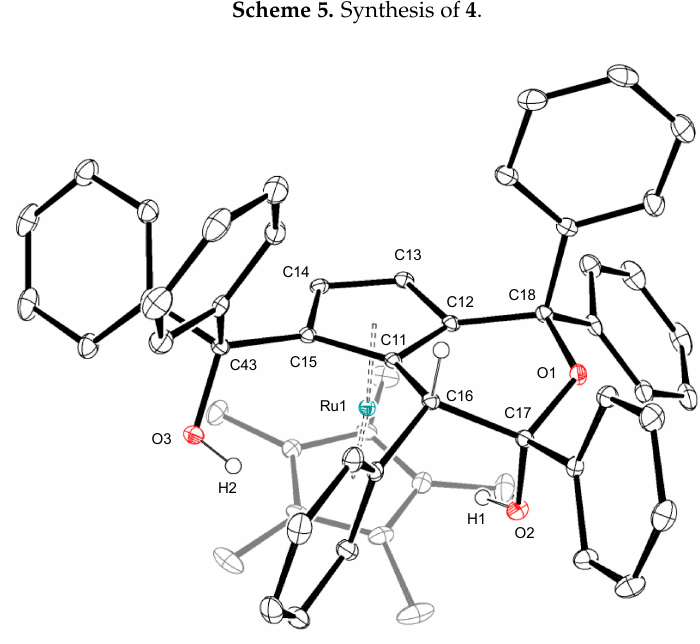
Figure 2. Crystal structure of 4 . Ellipsoids are drawn at the 30% probability level. Selected bond